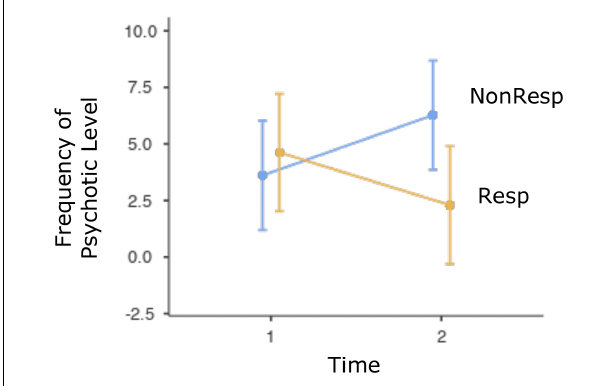
FIGURE 2 | Fixed effect plot with 95% CI for the evolution of psychotic level for responders and non-responders. Note. Resp, responders; Non-Resp, non-responders; Time 1, pretherapy; Time 2,